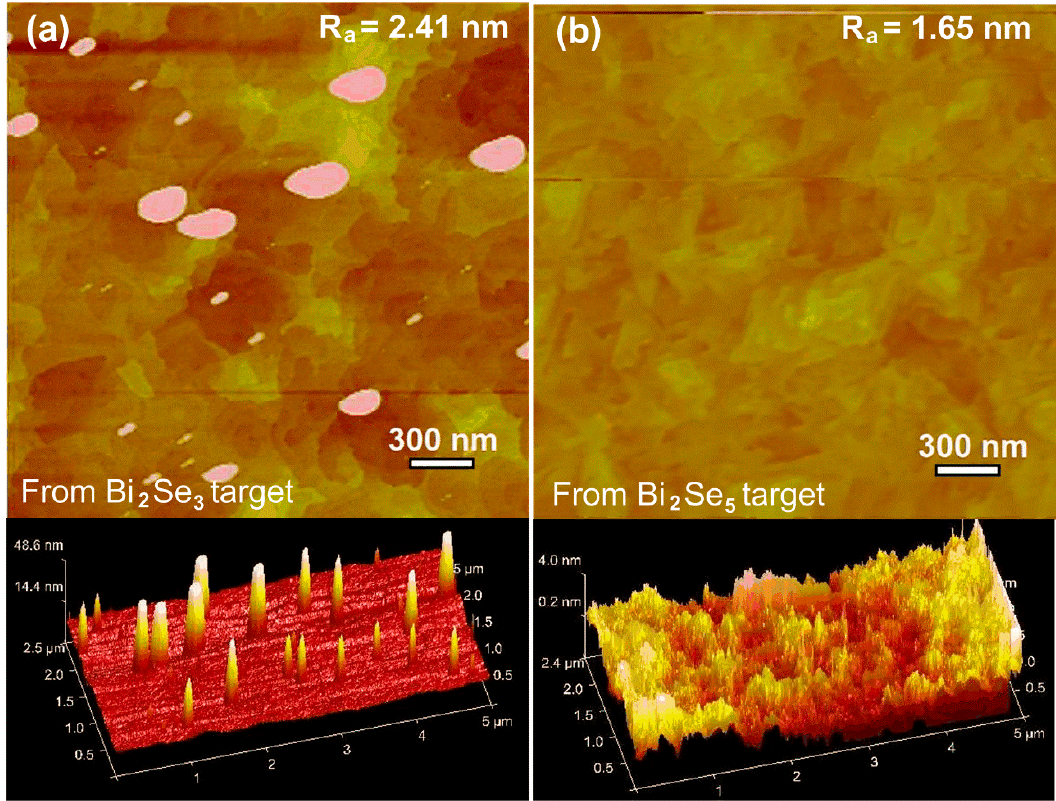
Figure 2. 2D and 3D AFM images of the Bi 2 Se 3 thin films deposited from ( a ) Bi 2 Se 3 target and ( b ) Bi 2 Se 5 target.